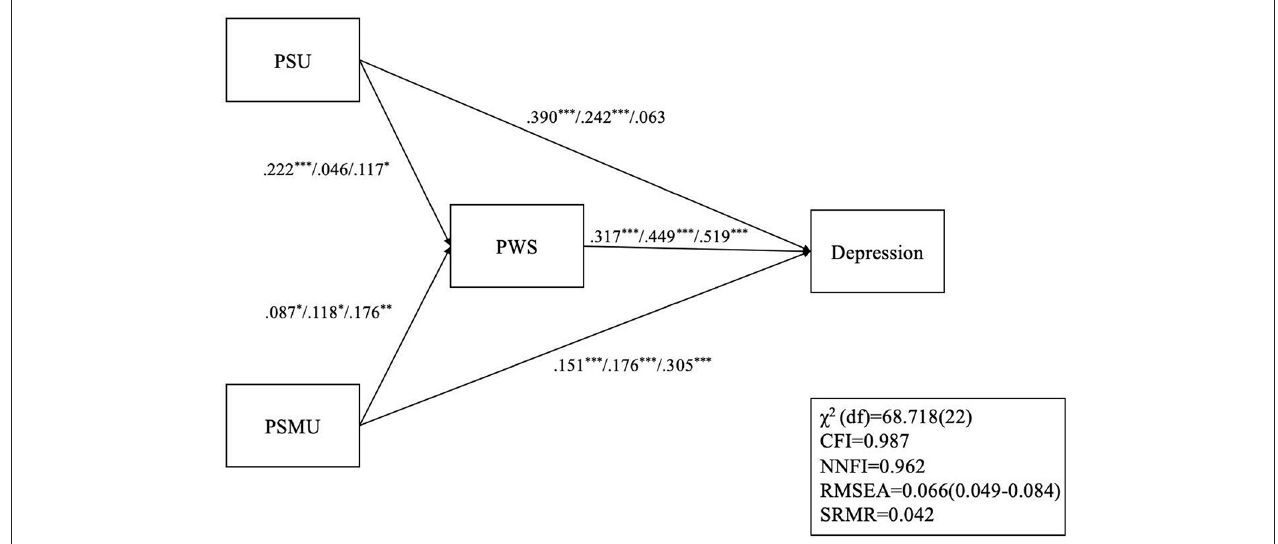
FIGURE 1 | Structural equation modeling with multiple group analysis on the relationship among PSU, PSMU, PSW, and depression. * p < 0.05; ** p < 0.01; *** p < 0.001; For each set of path coefficients, the first coefficient represents pre-COVID associations (Wave 1); the second coefficient represents associations during the COVID outbreak (Wave 2); the last coefficient represents post-COVID lockdown (Wave 3) associations; PSU, problematic smartphone use; PSMU, Problematic social media use; PWS, perceived weight stigma; CFI, Comparative fit index; NNFI, non-normed fit index; RMSEA, root mean square error of approximation; SRMR, standardized root mean square residual.